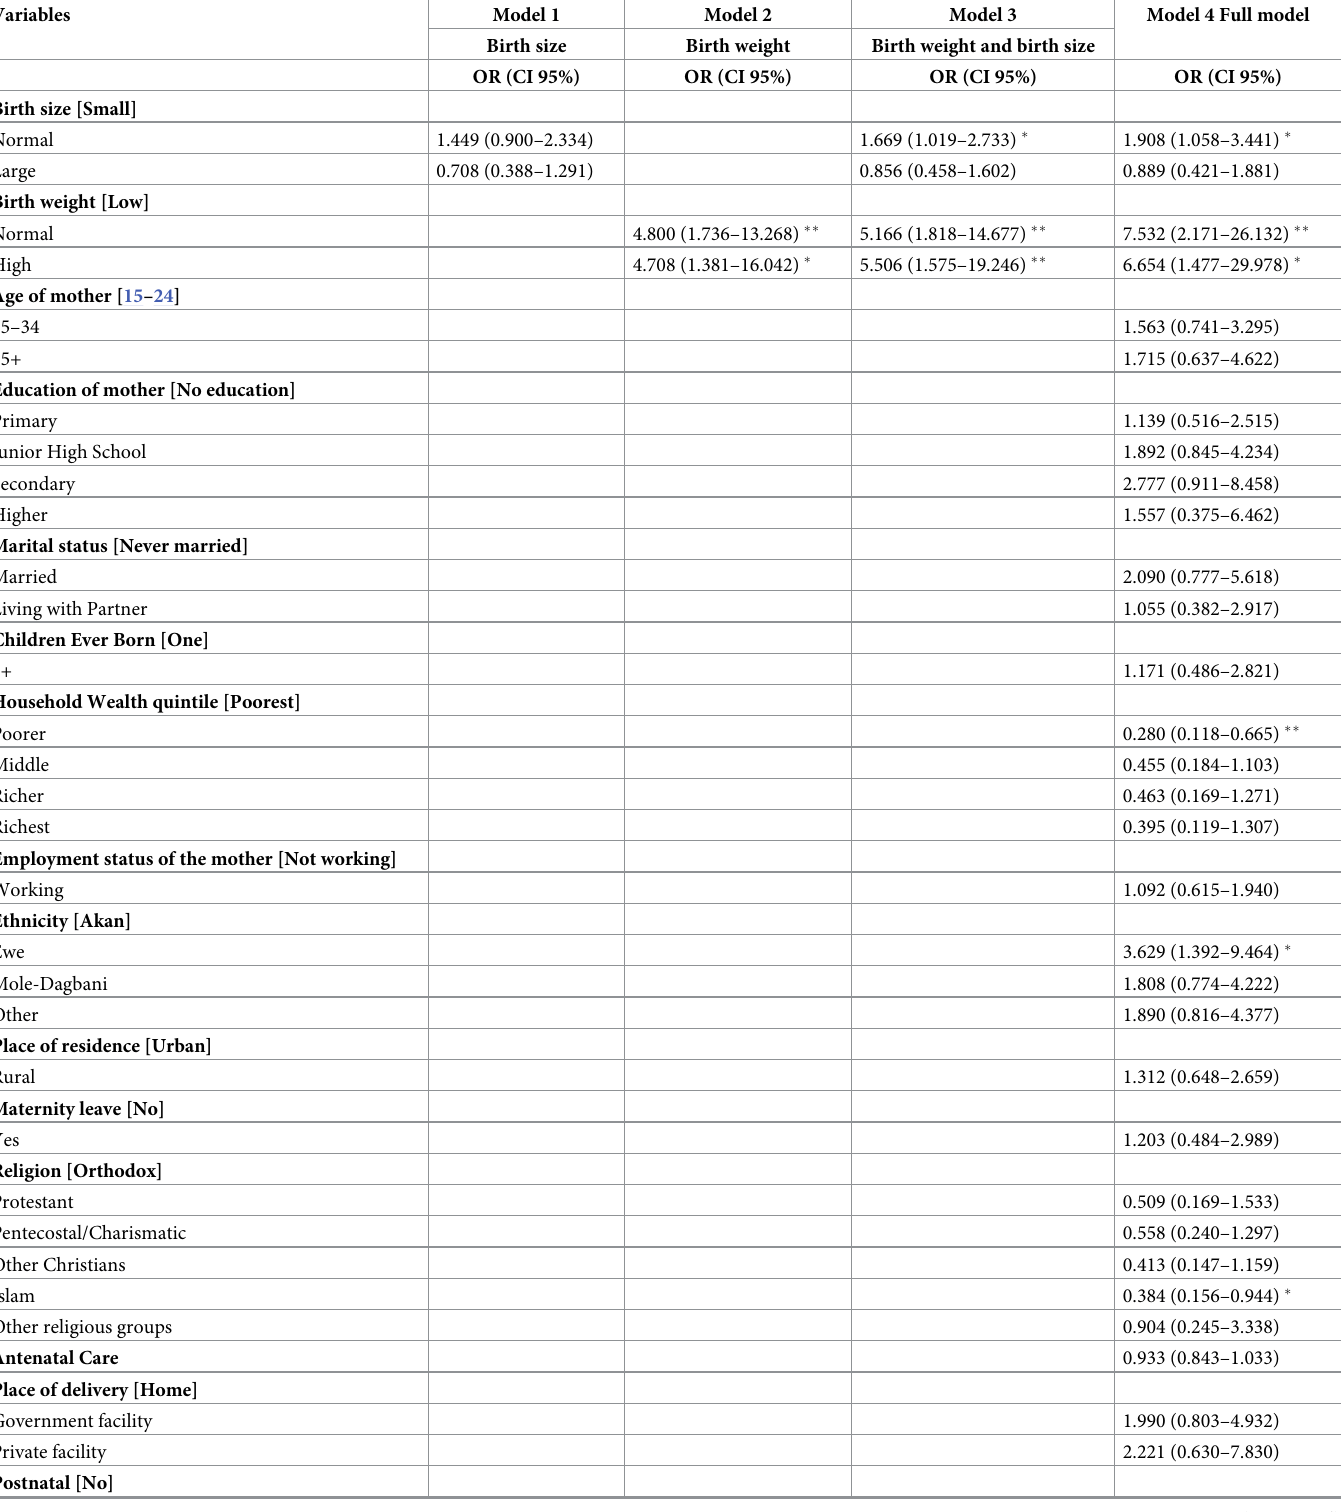
Table 2. Binary logistic regression showing predictors of exclusive breastfeeding among infants 0–5 months old surveyed in this